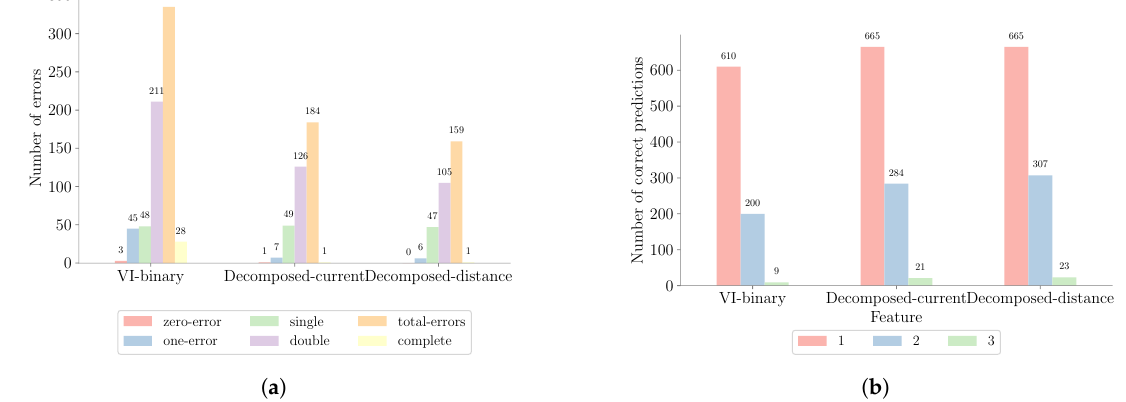
Figure 11. ( a ) Distributions of type errors the model makes. ( b ) Number of correct predictions for single, double and triple